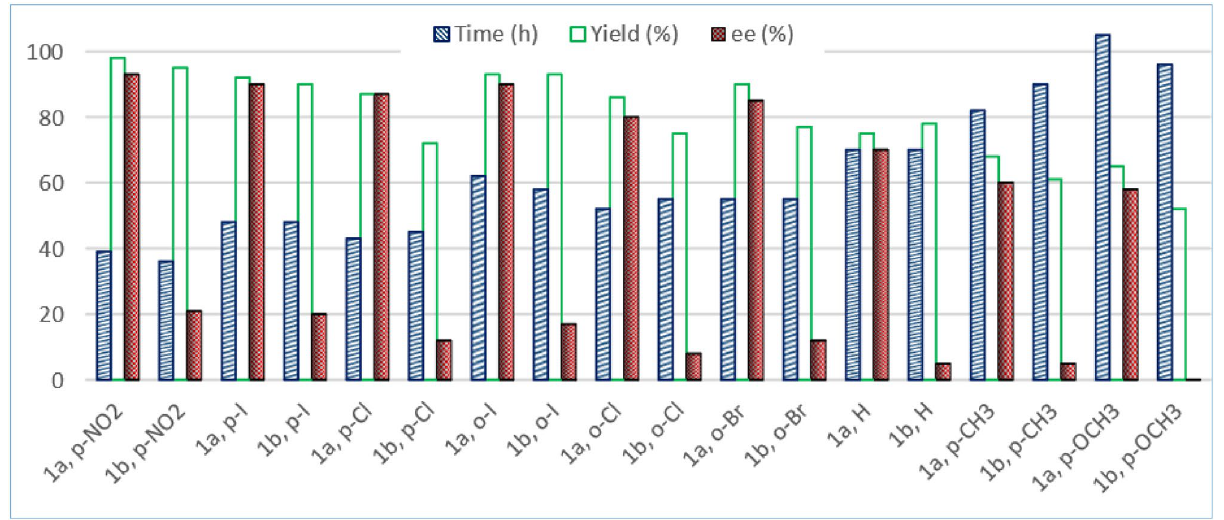
Figure 1. Comparison of the chiral ligands 1a and 1b in ee , yield and reaction